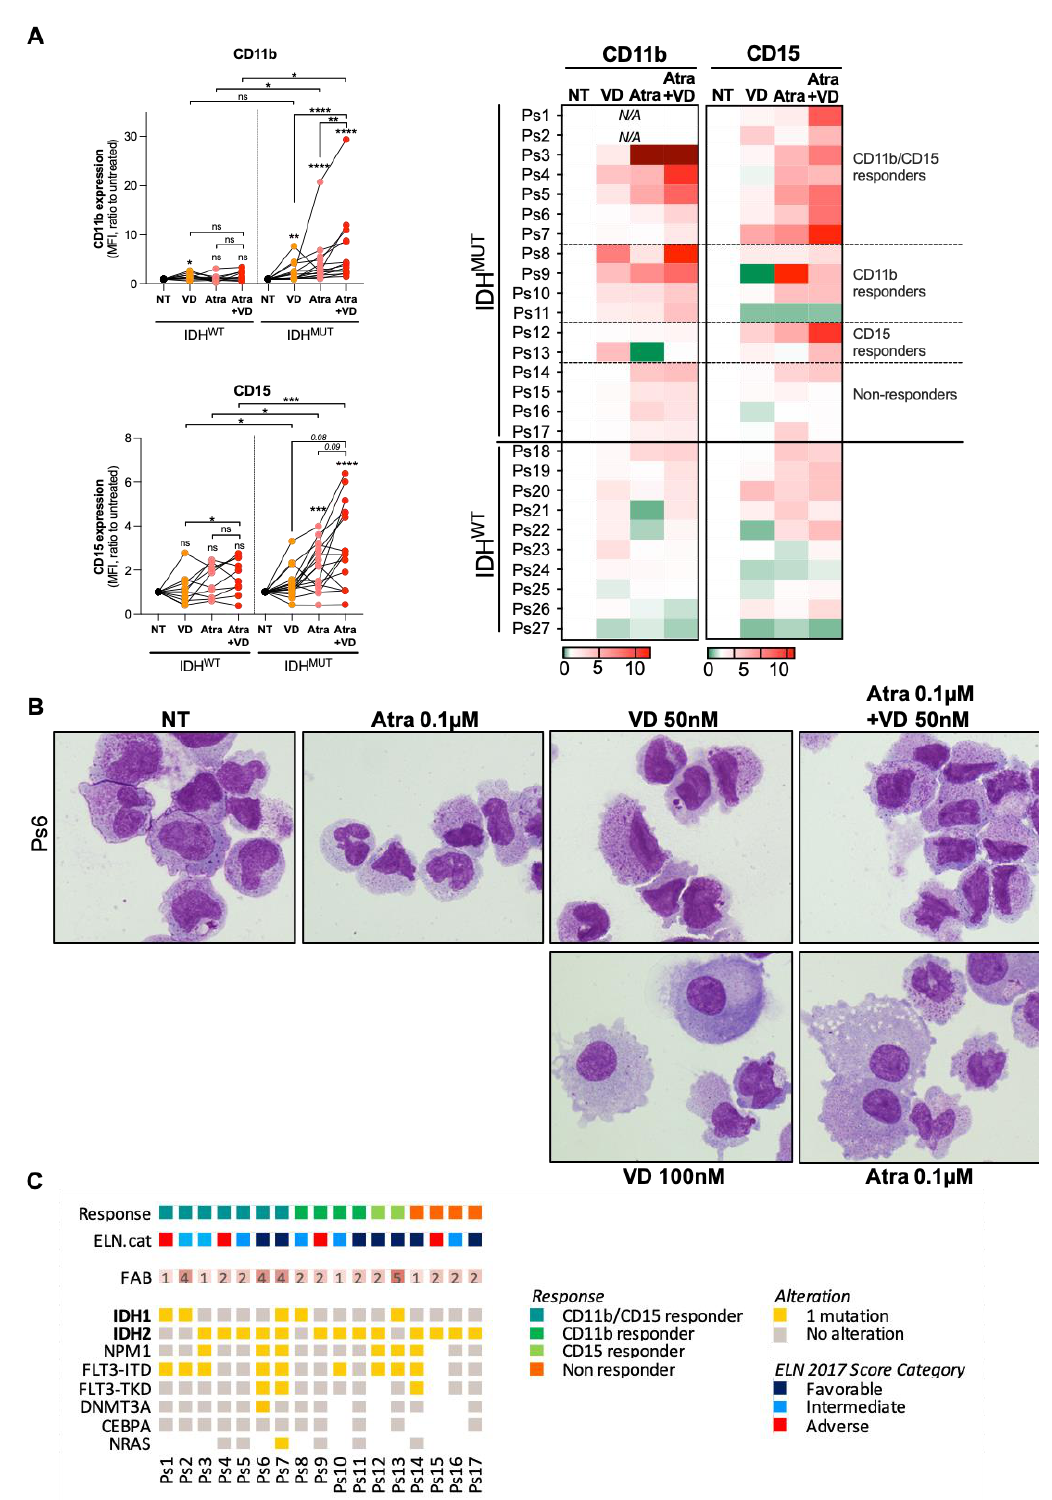
Figure 4. Targeting vitamin D receptor pathway enhances anti-AML effect with ATRA in IDH MUT AML patients. ( A ) CD11b and CD15 expressions (mean fluorescence intensity, MFI) measured by flow cytometry in IDH MUT versus IDH WT patients treated with ATRA and VD alone or in combination (left panel). Results for each patient are represented individually (right panel). ( B ) Morphological characterization by MGG staining of Ps6 treated for 14 days with ATRA 0.1 µ M and VD 50–100 nM alone or in combination. ( C ) Clinical characteristics of IDH MUT patients in function of their response to ATRA/VD-duplet therapy. * p < 0.05; ** p < 0.01, *** p < 0.005, **** p <